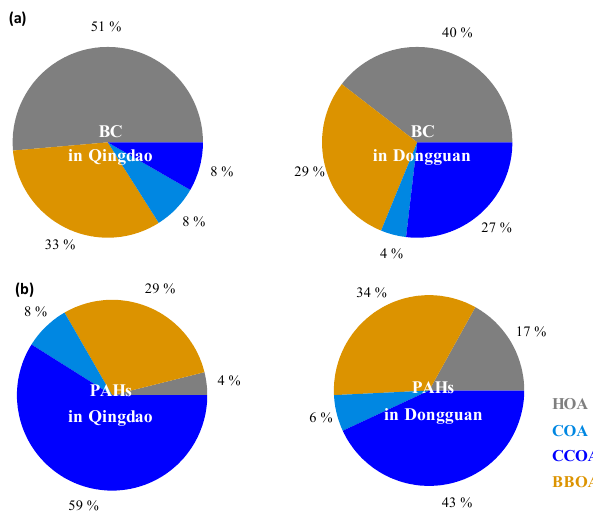
Figure 4. (a) Average contributions of POA factors to BC; (b) av- erage contributions of POA factors to